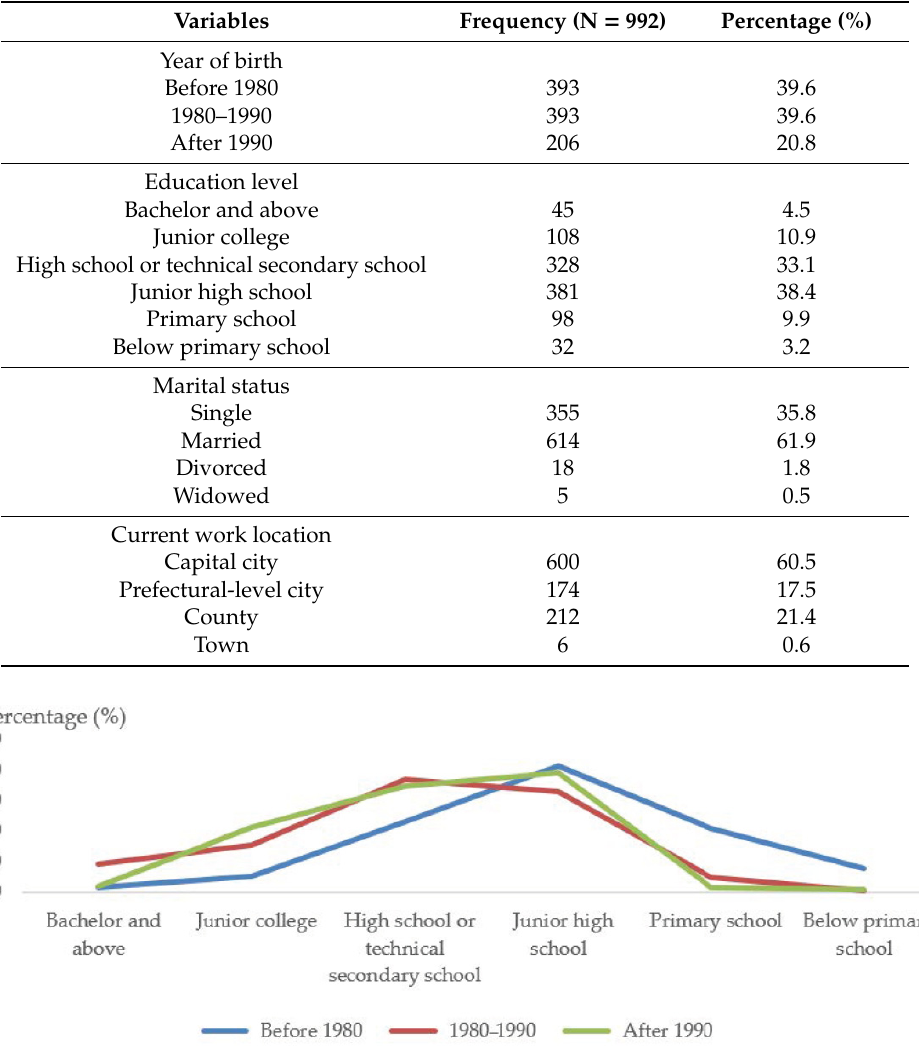
Table 1. Demographic information of questionnaire respondents.